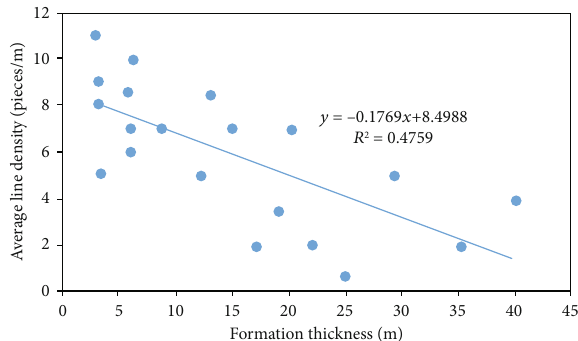
Figure 9: Relationship between shale fracture development and stratum thickness in the Longmaxi Formation in Yushenjing District, southeastern